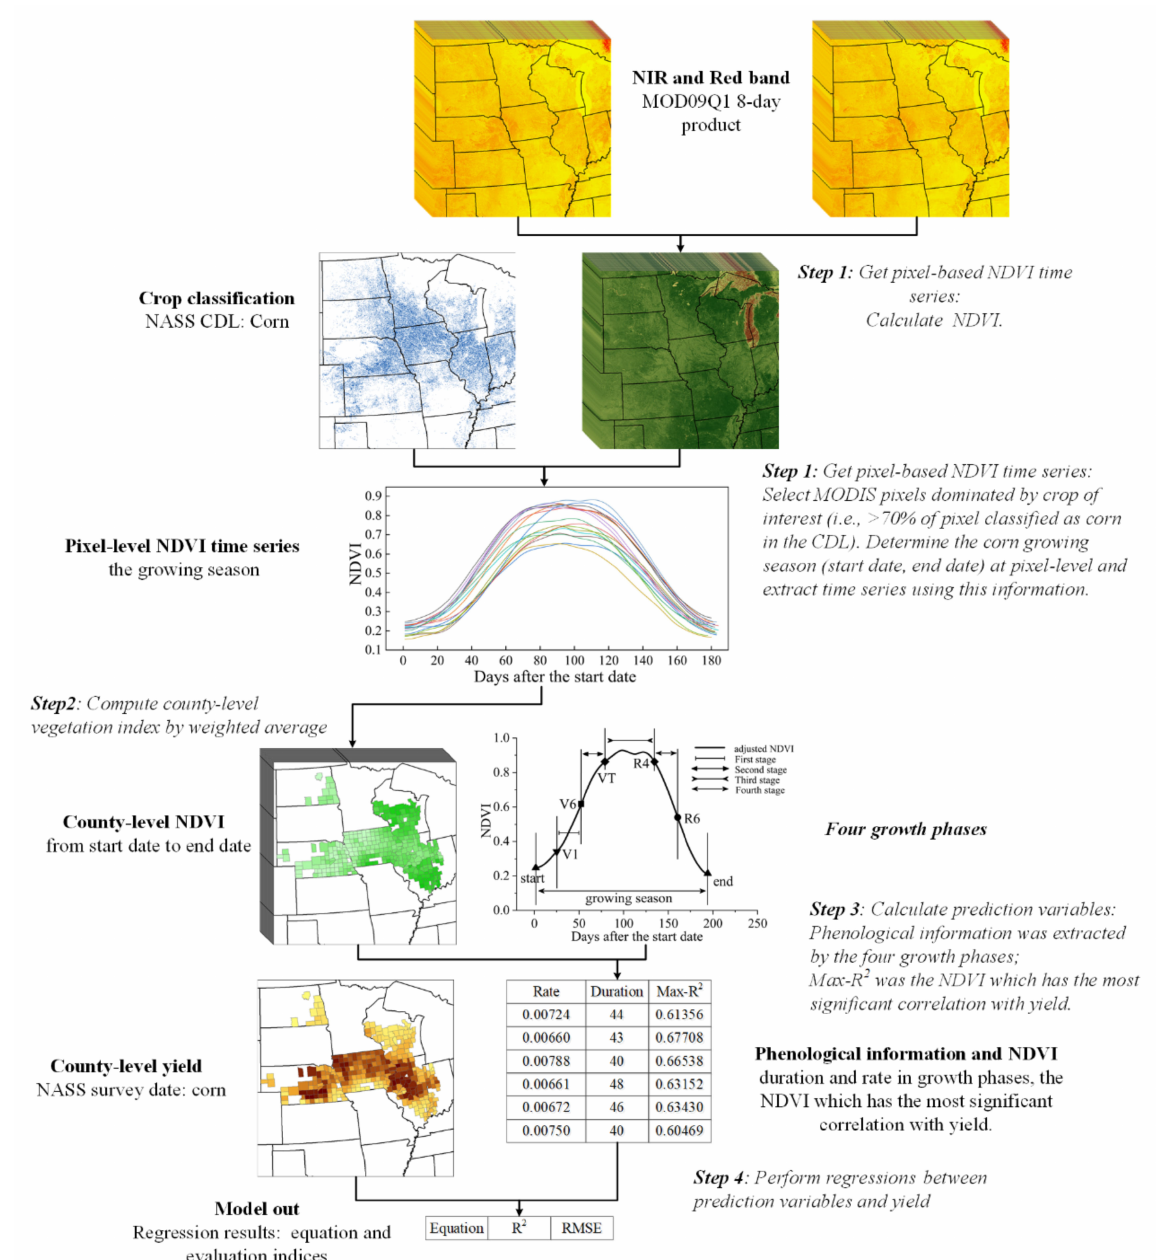
Figure 2. Flow diagram of the datasets and processing used in the model, indicating four steps of model development: 1— obtaining the normalized difference vegetation index (NDVI) time series from the start date to end date of corn at a pixel level, 2—computing the county-level NDVI time series, 3—deriving the prediction variables (duration and rate in four growth phases, maximum correlation NDVI), and 4—constructing the regression relationships between the corn yield and